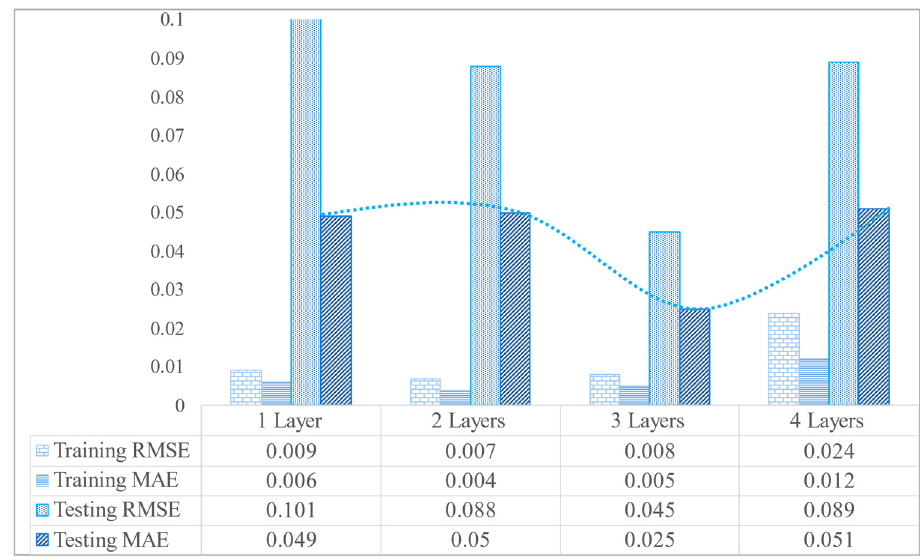
Figure 6. Evaluation indexes of prediction accuracy of ANN model under different hidden layers.